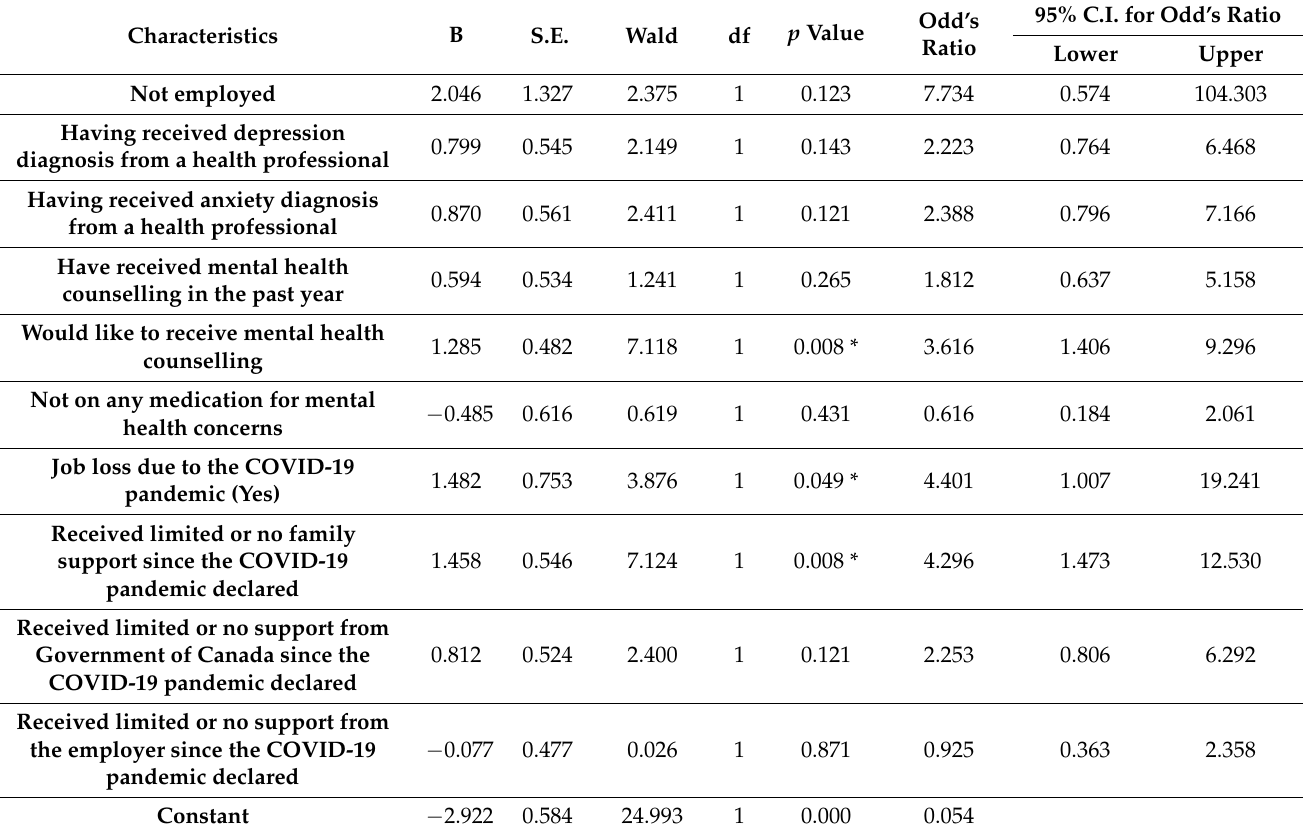
Table 3. Logistic regression model for respondents’ likelihood to present with moderate-to- severe